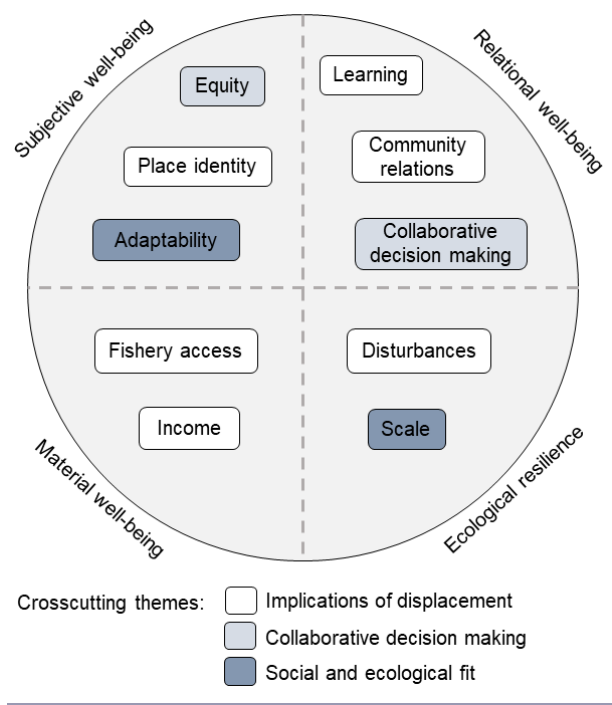
Fig. 3 . Thematic categorization of the perceived costs of marine protected